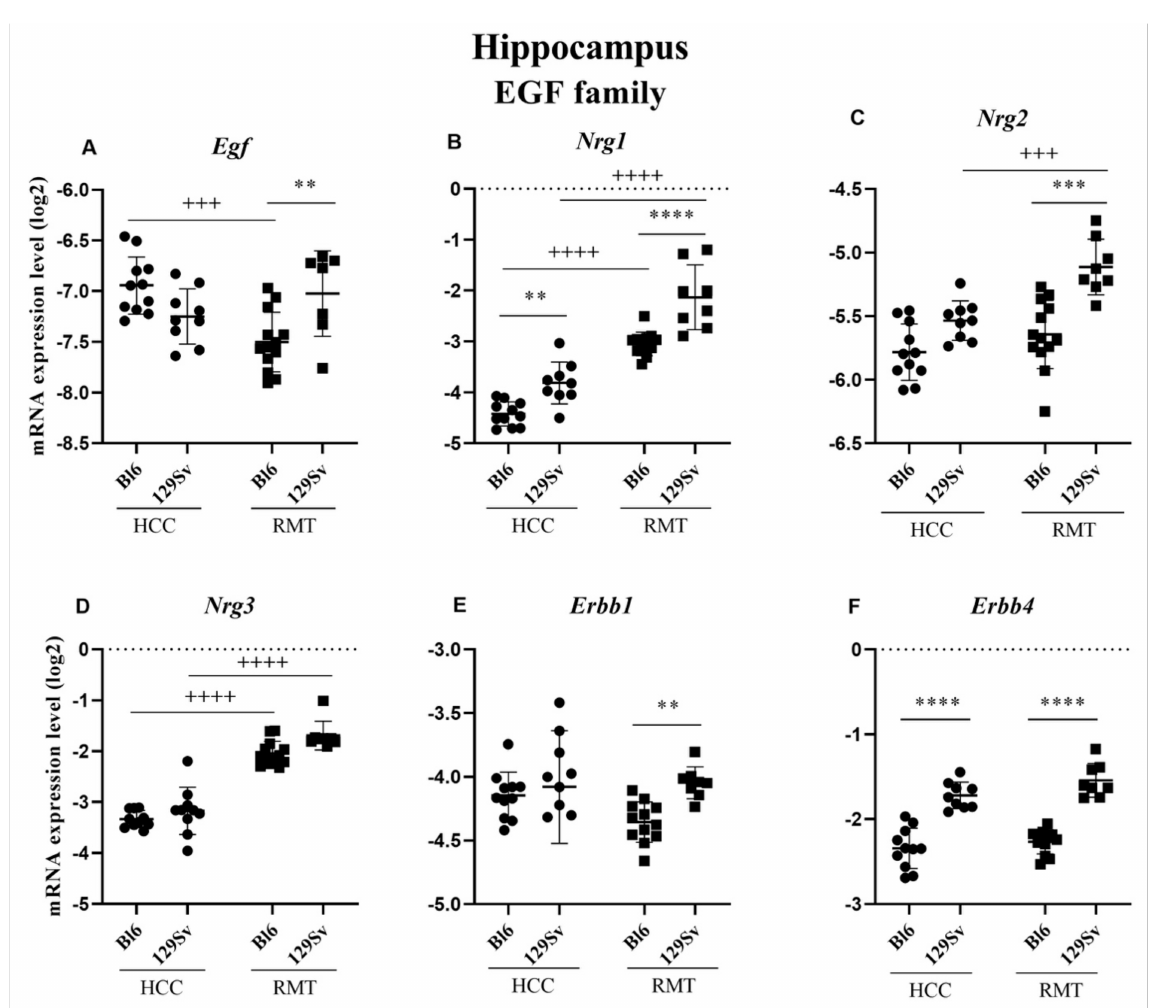
Figure 11. Egf family gene expression in the hippocampus of Bl6 and 129Sv mice. Two-way ANOVA was applied to demonstrate differences between the strains and environments. Substantial statistically significant gene expressions for ( A ) Egf —epidermal growth factor, ( B ) Nrg1 —neuregulin 1, ( C ) Nrg2 —neuregulin 2, ( D ) Nrg3 —neuregulin 3, ( E ) Erbb1 — epidermal growth factor receptor and ( F ) Erbb4 —erb–b2 receptor tyrosine kinase 4. Bonferroni post hoc test: * p ≤ 0.05, ** p ≤ 0.01 *** p ≤ 0.001 and **** p ≤ 0.0001 compared to respective 129Sv mice, +++ p ≤ 0.001 and ++++ p ≤ 0.0001 in strain specific comparison. Data are expressed as mean values ± SD. Number of animals in each group varied from 7 to 13. Ventral Striatum (Figure 12, Table S1) In the ventral striatum, the expression differences in the EGF family were less promi- nent compared to the frontal cortex and hippocampus. In HCC 129Sv mice, the level of Egf ( p = 0.05) was reduced compared to HCC Bl6 (Figure 12A). In response to RMT, the level of Nrg1 ( p = 0.0002 for Bl6 and p = 0.003 for 129Sv) was reduced, whereas the level of Nrg3 ( p = 0.0003 for Bl6 and p ≤ 0.0001 for 129Sv) was increased in both strains (Figure 12B,C). The expression levels of Egf ( p ≤ 0.0001) and its receptor Erbb1 ( p = 0.004) were significantly elevated if RMT and HCC 129Sv mice were compared (Figure